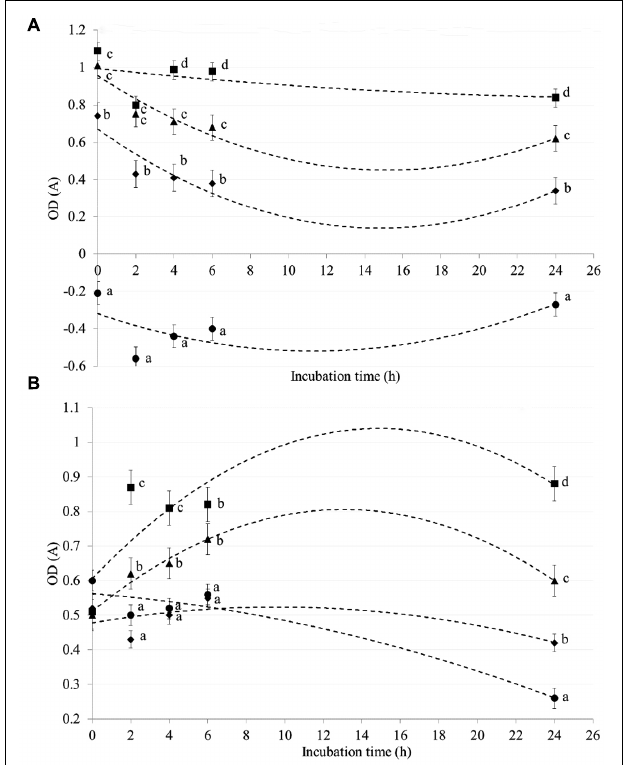
FIGURE 3 | In vitro adsorptive capacity of chabazitic zeolitite (CZ) toward Escherichia coli (A) and Clostridium perfringens (B). CZ levels: ( (cid:4) ) 0 g, ( (cid:78) ) 0.25 g, ( (cid:7) ) 0.5 g,